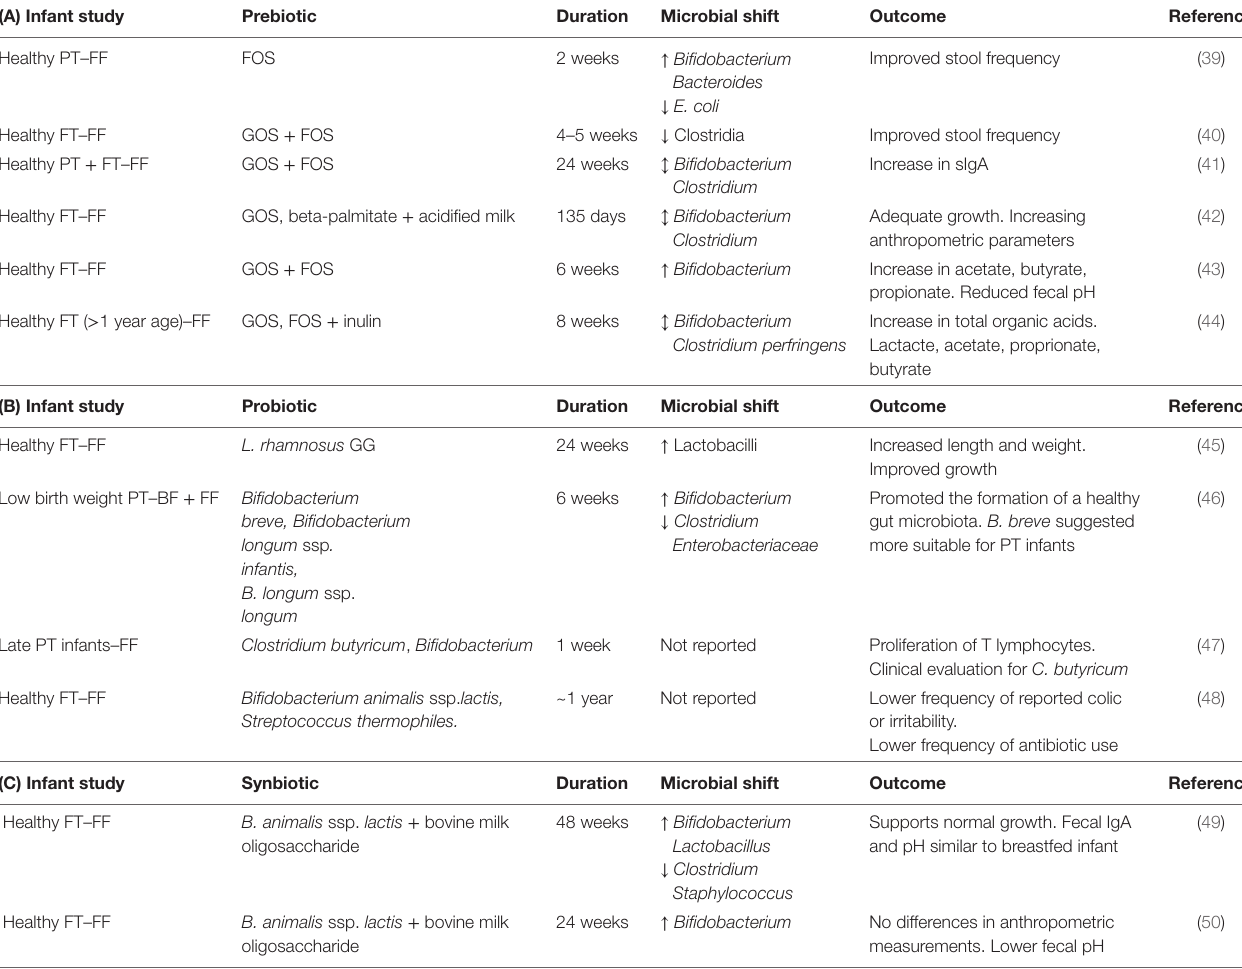
TaBle 1 | (A) Prebiotics effective in altering the intestinal microbiota in human infant studies, (B) probiotic strains effective in altering the intestinal microbiota in a number of human infant studies, and (C) synbiotics effective in altering the intestinal microbiota in a number of human infant